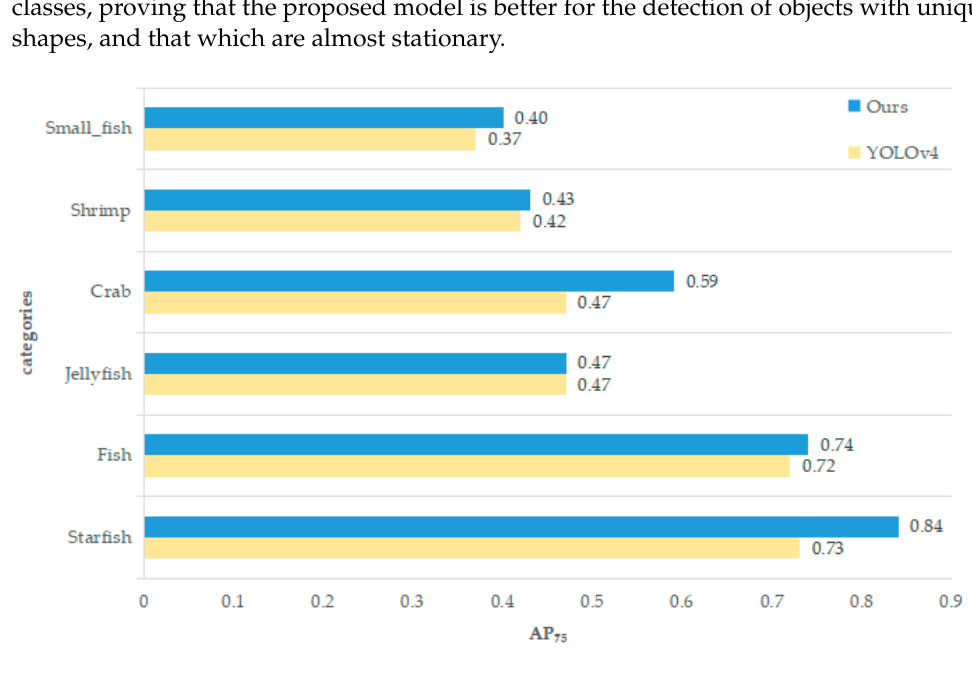
Figure 5. The detection results of our method in Brackish dataset. The detected crab in light blue box, fish in red box, jellyfish in dark blue box, shrimp in green box, small fish in yellow box and starfish in pink box. 4. Conclusions